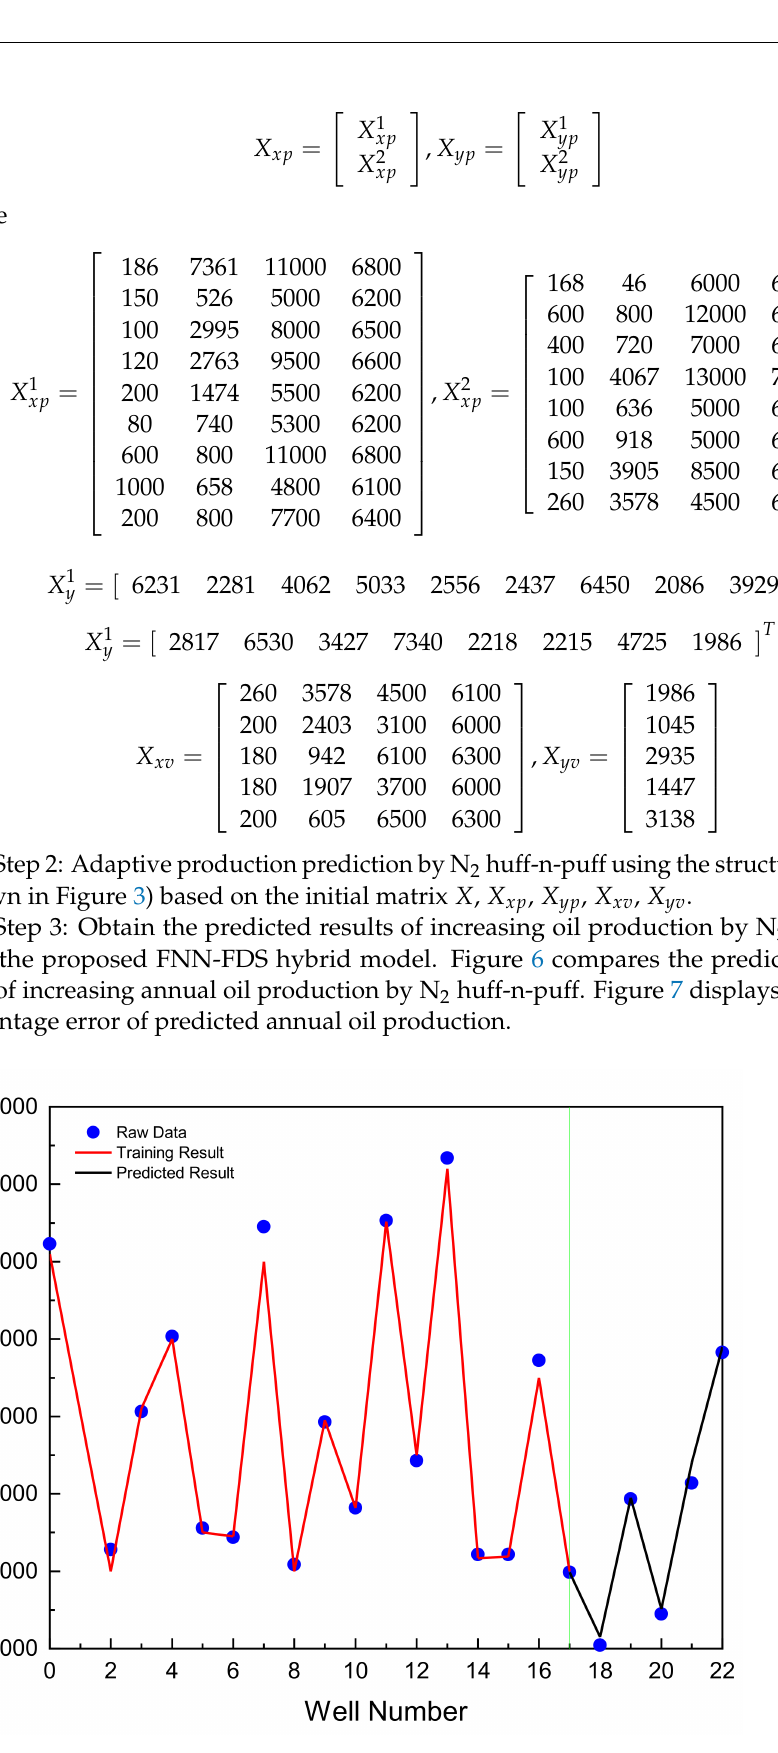
Figure 6. Comparison of predicted and actual annual oil production by N 2